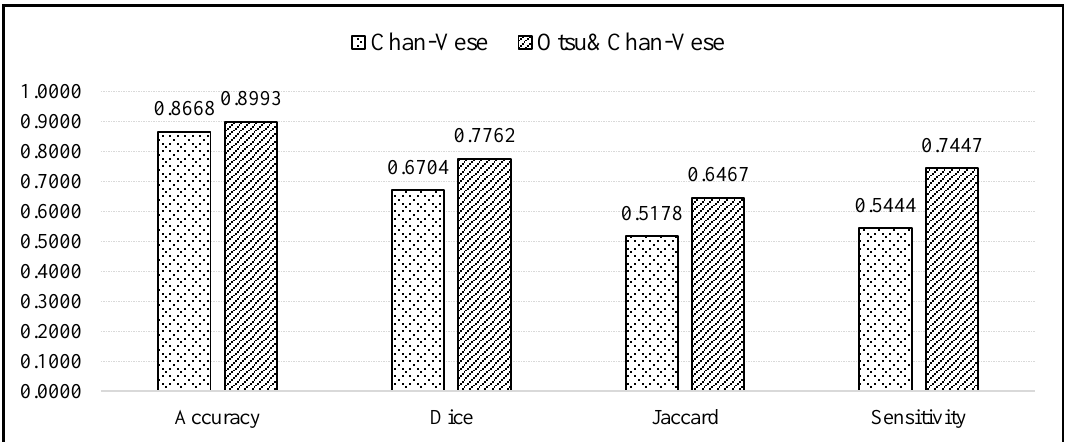
Figure 14. Bar chart comparing the accuracy, Dice Score, Jaccard Index, and sensitivity of the classical Chan – Vese method and the proposed method.